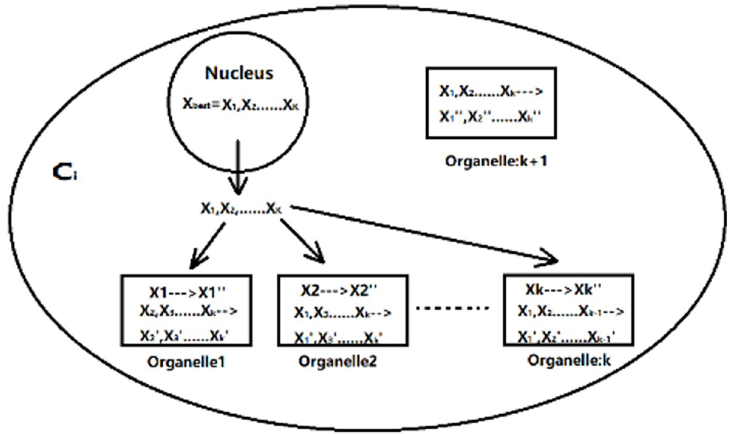
Fig 3. Simplified diagram of the new solution model of MSA cell individual